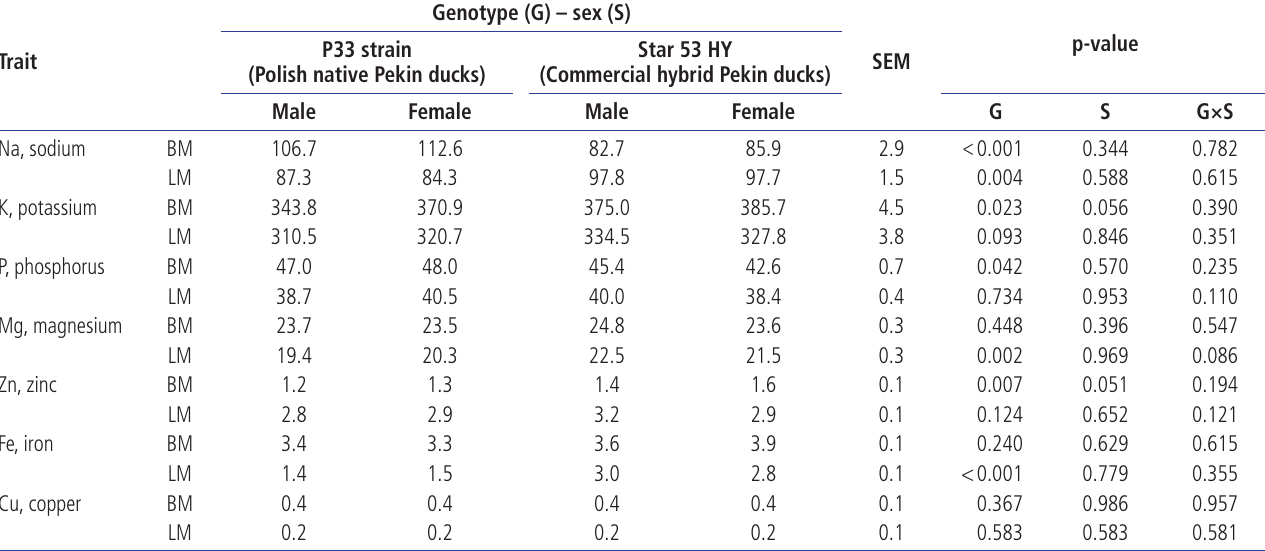
Table 5. Content of some minerals in mg/100 g of breast and leg meat from 49-d-old Pekin ducks of different genotypes